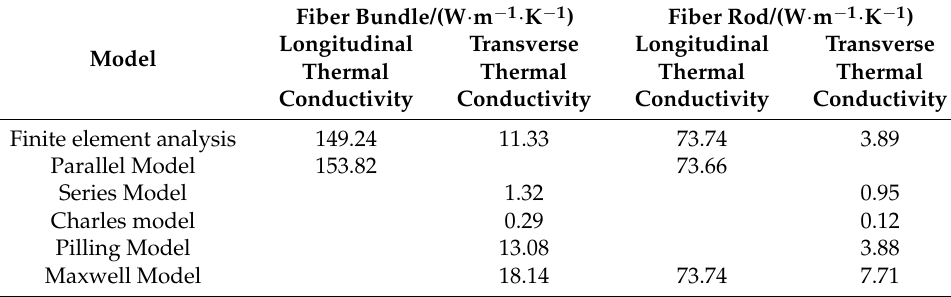
Figure 10. Temperature and heat flux distributions of the carbon fiber rod: ( a ) temperature, ( b ) heat flux. Table 2. Comparison of results by the FEM analysis and